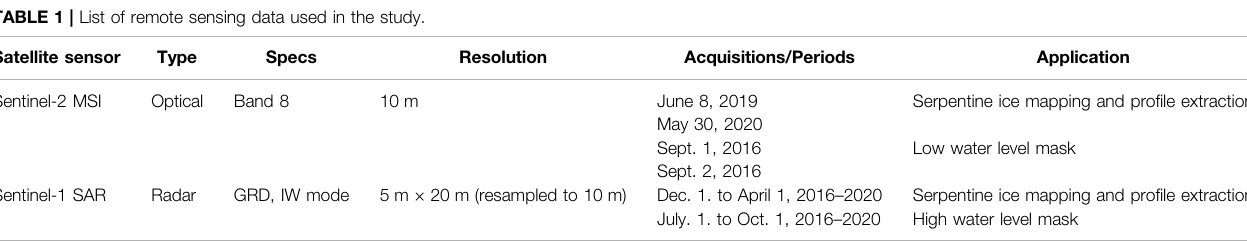
TABLE 1 | List of remote sensing data used in the